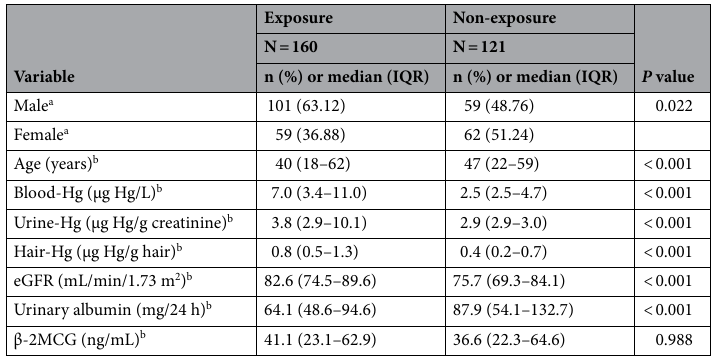
Table 1. Sociodemographic characteristics, exposure and effect biomarkers of study population. Hg mercury, β-2MCG β-2-microglobulin, eGFR estimated glomerular filtration rate, IQR interquartile range. a Pearson’s Chi- square test. b Mann–Whitney U test/Wilconxon rank-sum test for differences between